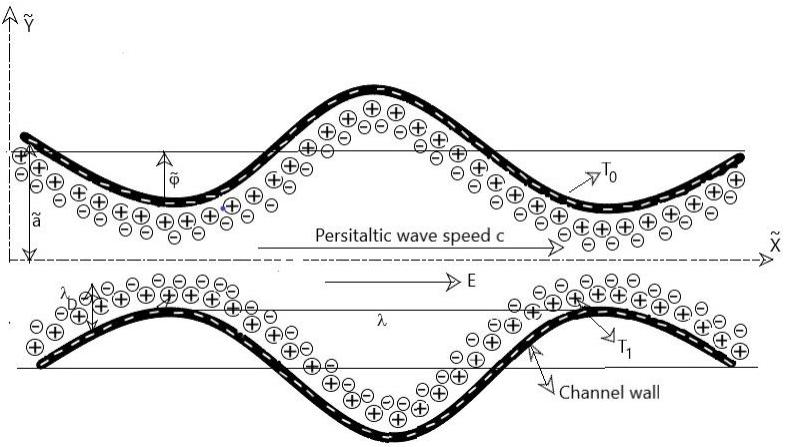
Figure 1. Geometry of electroosmotic flow